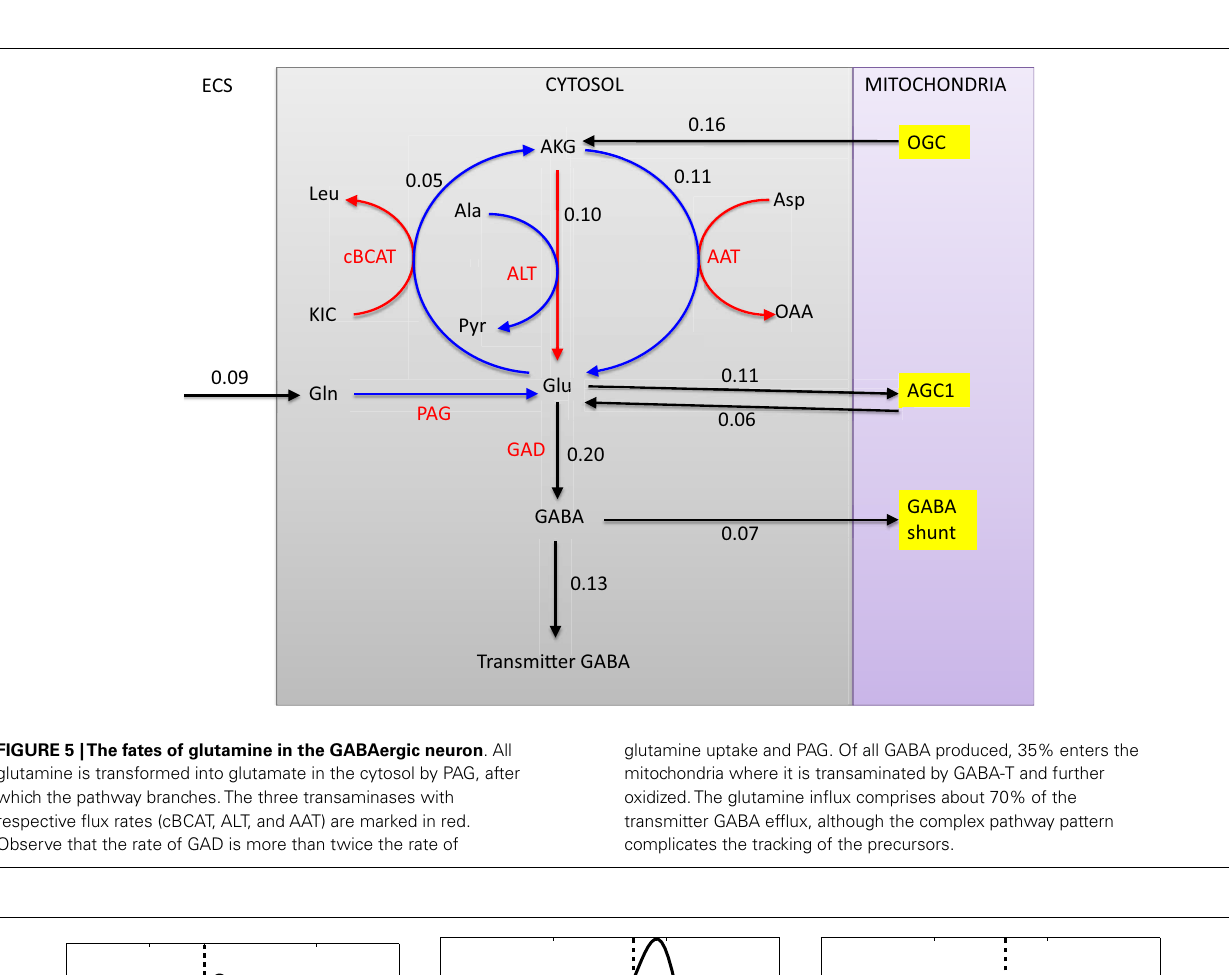
FIGURE 5 |The fates of glutamine in the GABAergic neuron . All glutamine is transformed into glutamate in the cytosol by PAG, after which the pathway branches.The three transaminases with respective flux rates (cBCAT, ALT, and AAT) are marked in red. Observe that the rate of GAD is more than twice the rate of